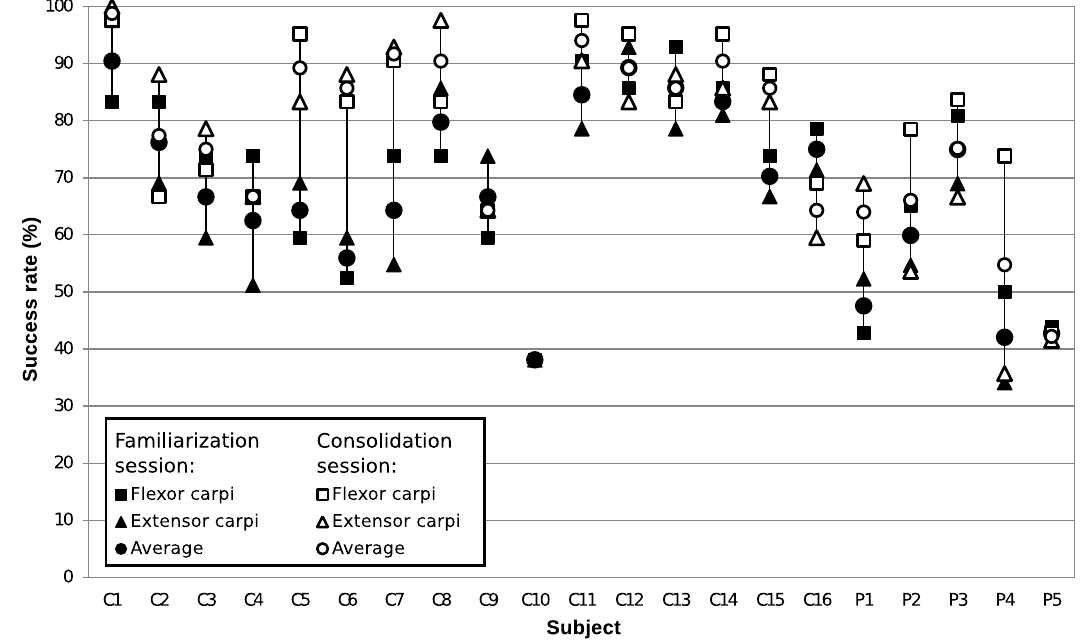
Figure 6. Success rate (SR) for the Myo-Pong at low difficulty. C is for the control subjects. P is for the patients. C10 played in the familiarisation session for just a short